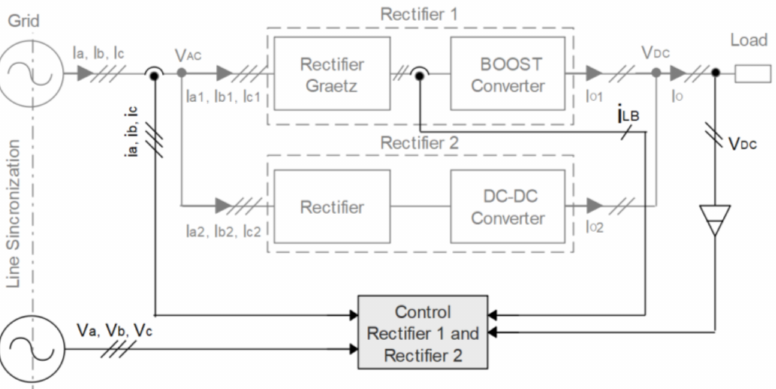
Figure 27. Configuration of electrical circuit applied in HTR with sinusoidal